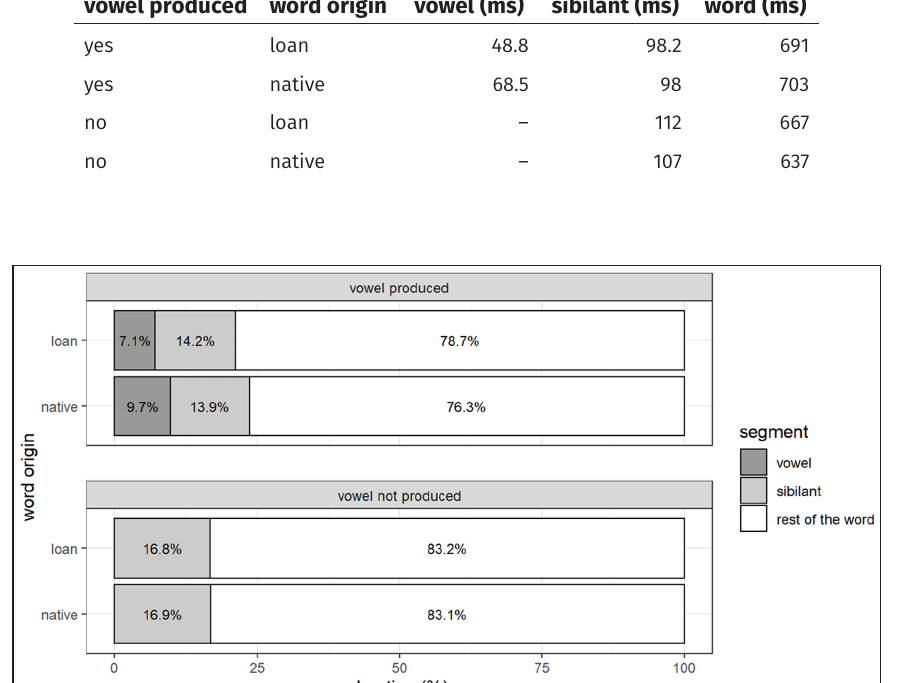
Table 2: Mean values for vowel, sibilant and word duration sampled by vowel occurrence and native/loan words.